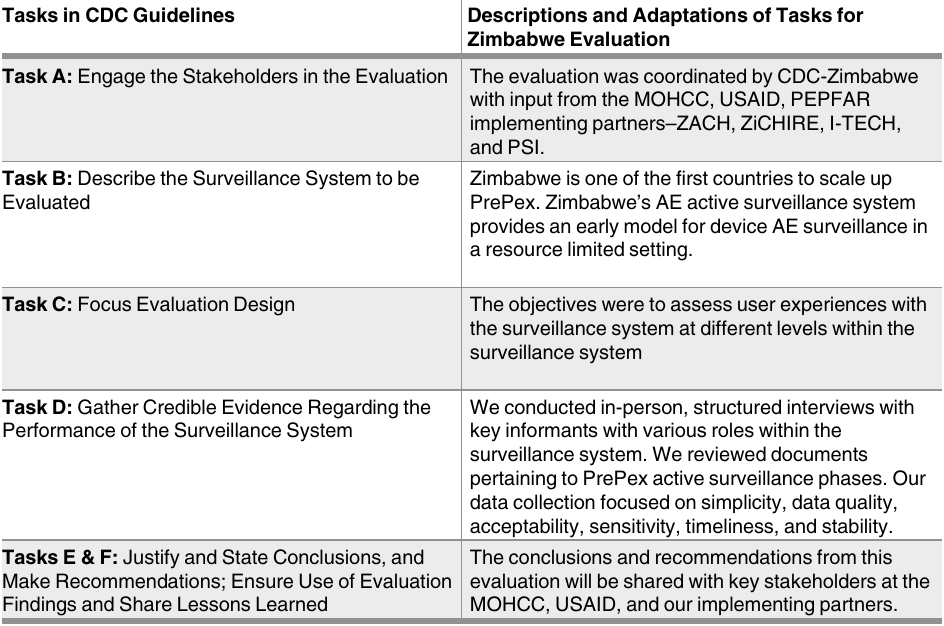
Table 1. Adaptations of CDC’s Updated Guidelines for Evaluating Public Health SurveillanceSystems for the PrePex adverseevents surveillance systemevaluation in Zimbabwe. Tasks in CDC